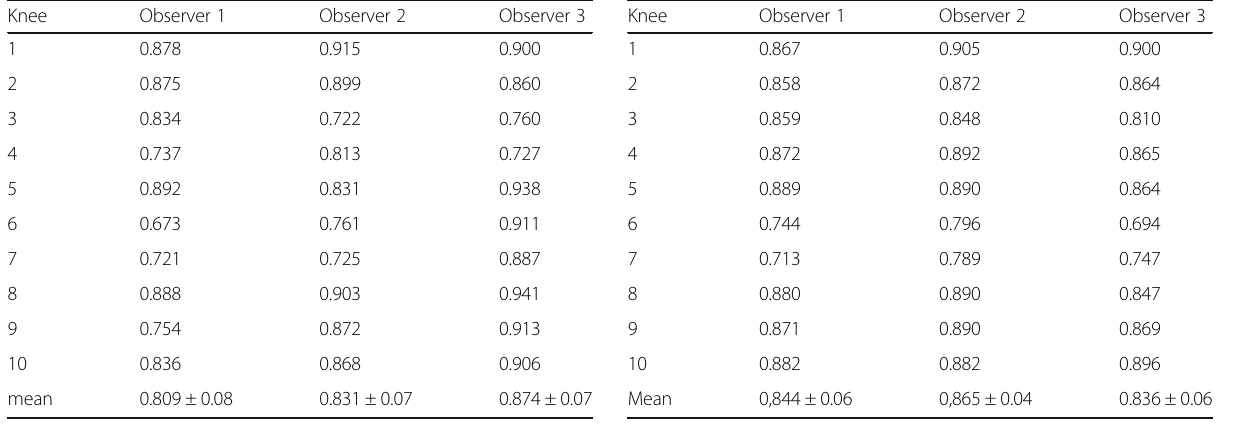
Table 1 Dice coefficient spectral unmixed vs white light Table 2 Dice coefficient Interobserver variability white